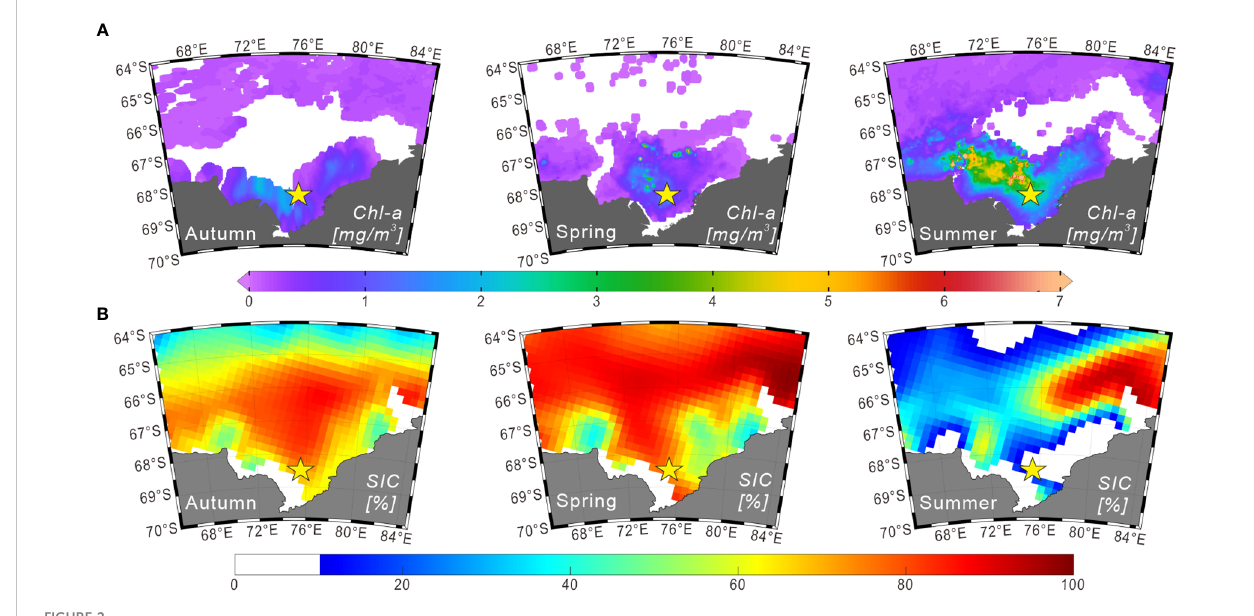
FIGURE 2 Seasonal distributions of chlorophyll a and sea-ice concentrations (2014 – 2015) in Prydz Bay and adjacent areas. (A) Seasonal chlorophyll a concentration data in the surface ocean derived from Aqua-MODIS products (https://oceanwatch.pifsc.noaa.gov/erddap/griddap). The durations of autumn, spring and summer were de fi ned as March 01 to June 01, 2014; September 01 to December 01, 2014; and December 01, 2014 to March 01, 2015, respectively. (B) Seasonal sea-ice concentration data obtained from the climatology data set (2014 – 2015) of the National Snow and Ice Data Center (https://nsidc.org). The durations of autumn, spring and summer were de fi ned as March – April – May, September – October – November, and December – January – February of 2014 and 2015,